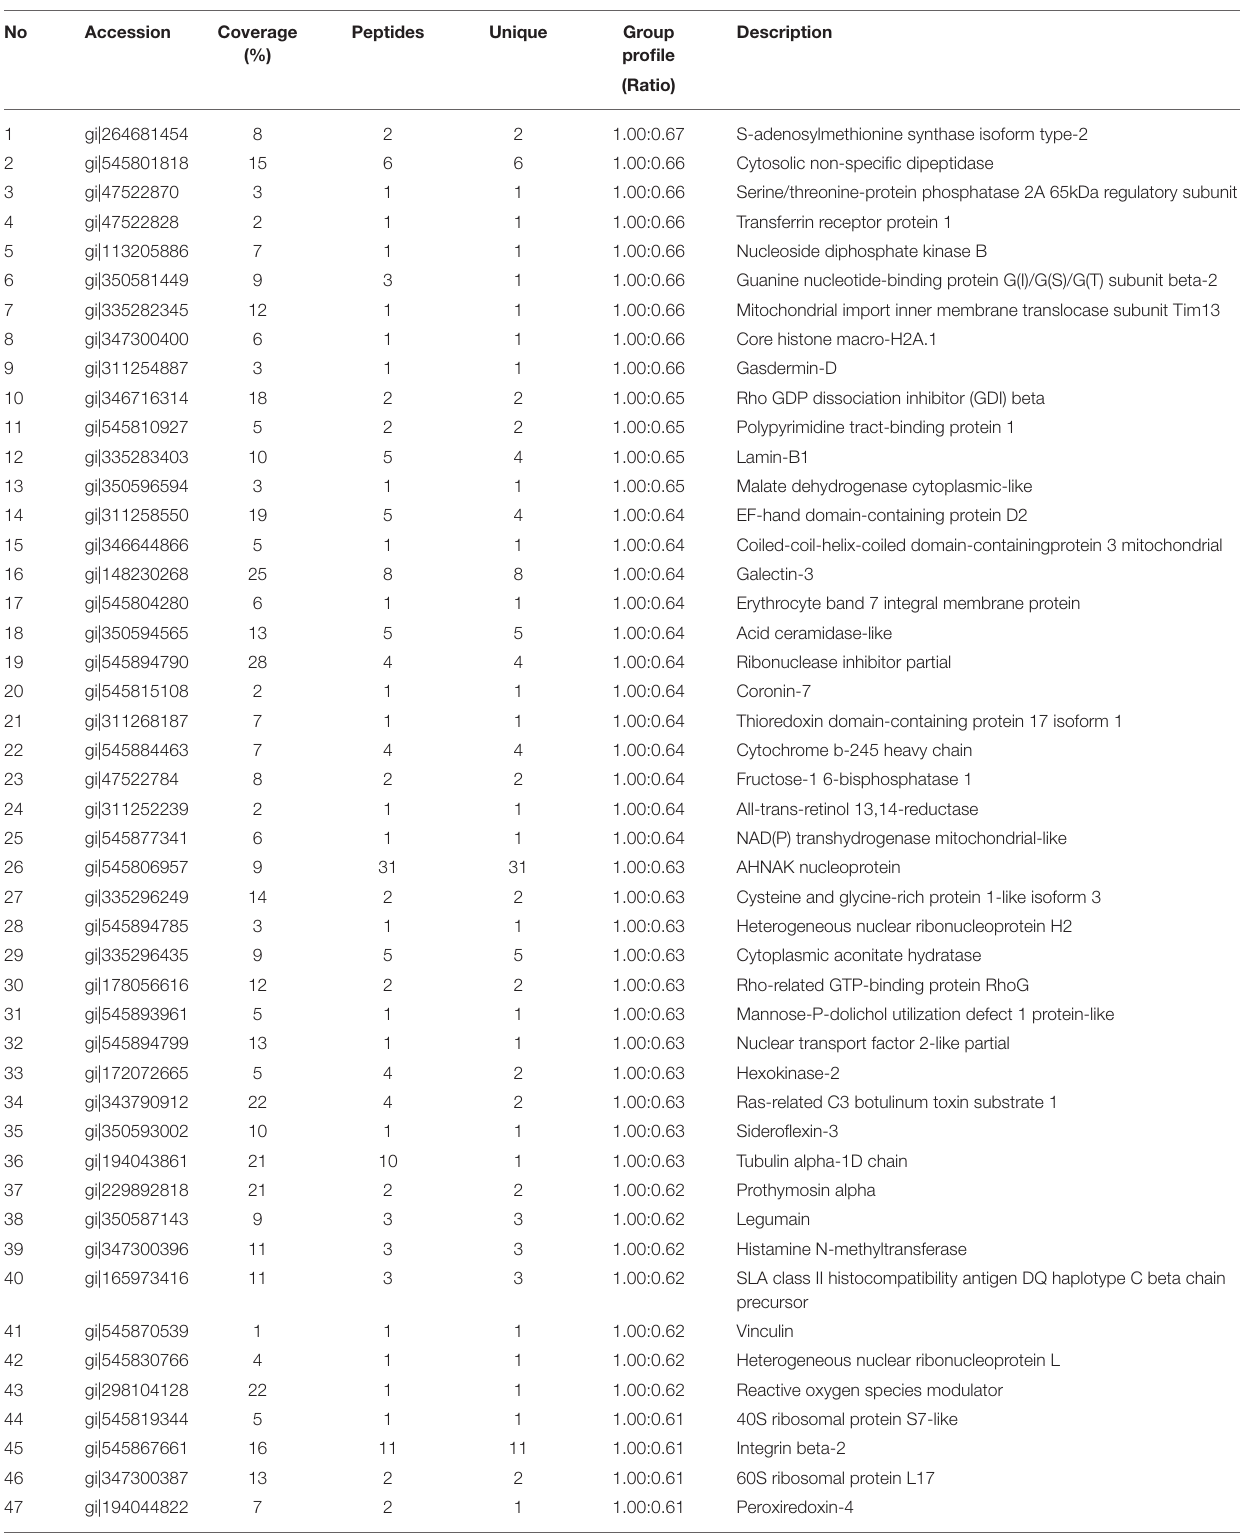
TABLE 2 | The significantly down-regulated proteins in HP-PRRSV HN07-1-infected PAMs identified by